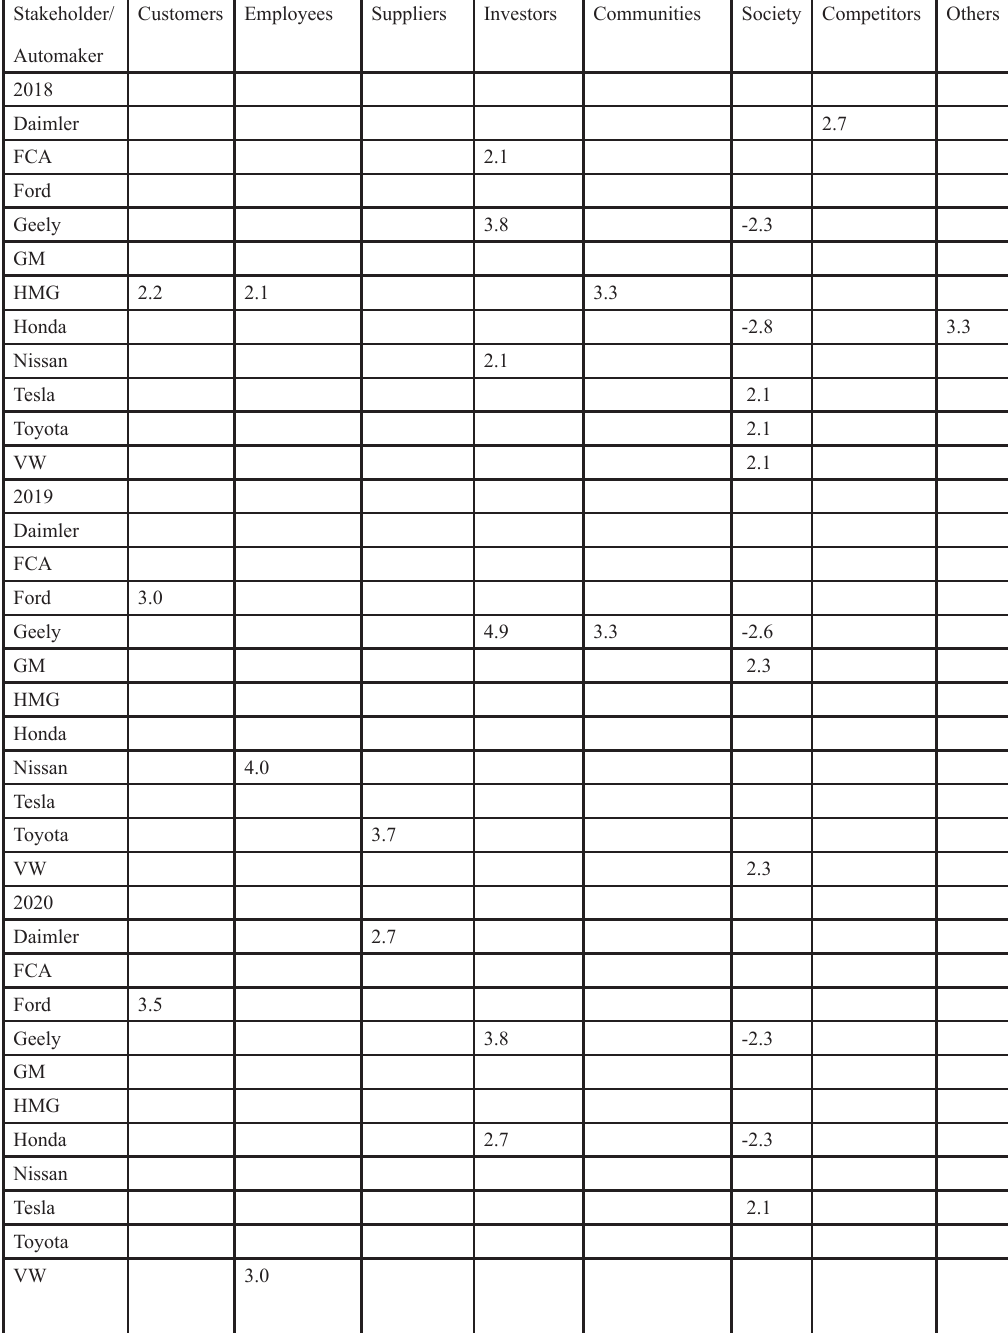
Table 2: Significant Adjusted Standardized Residuals of Key Stakeholders by Automakers Across Years